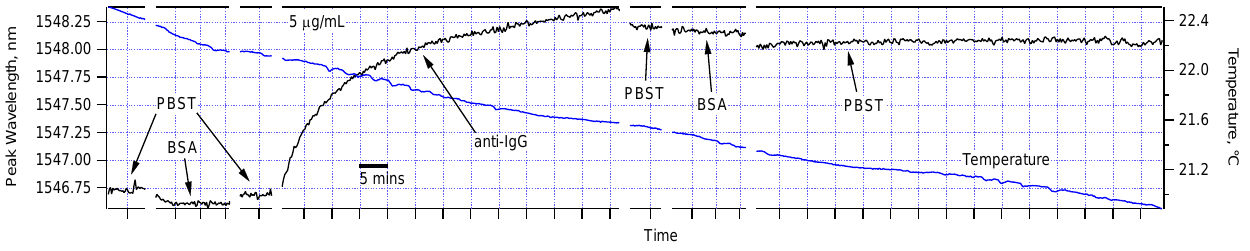
Figure 4. The functionalized sensor was sequentially immersed in PBST, BSA (5 µg/mL), PBST, anti-IgG (5 µg/mL), PBST, BSA (5 µg/mL), and PBST. As indicated by the scale bar, each horizontal division is 5 min. Temperature variation during of the water bath was also simultaneously recorded during the experiment and was shown